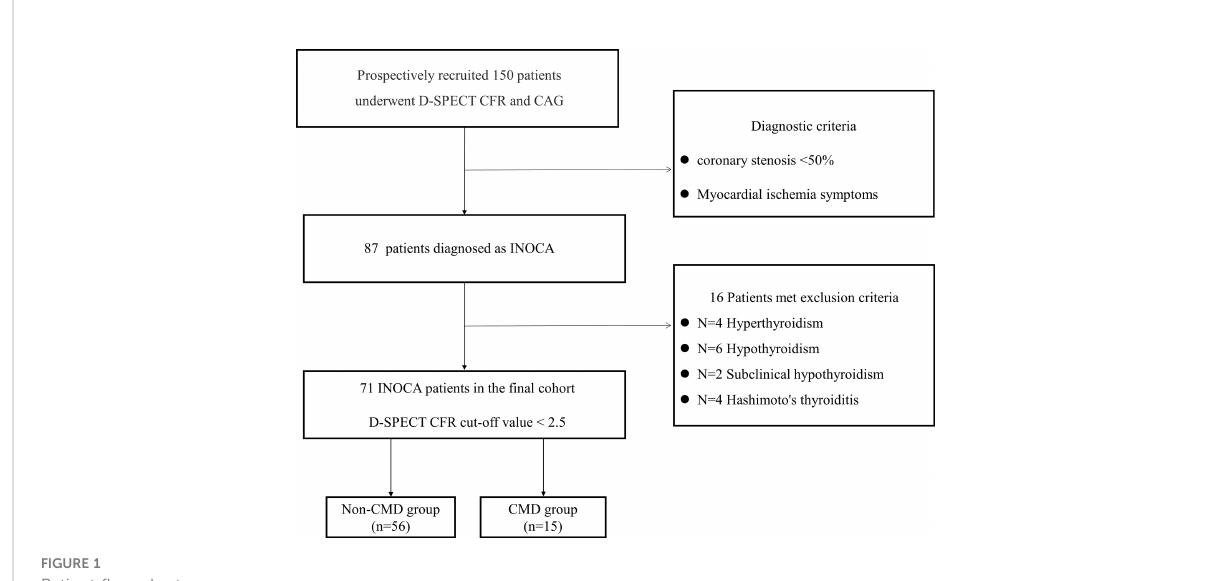
FIGURE 1 Patient fl ow